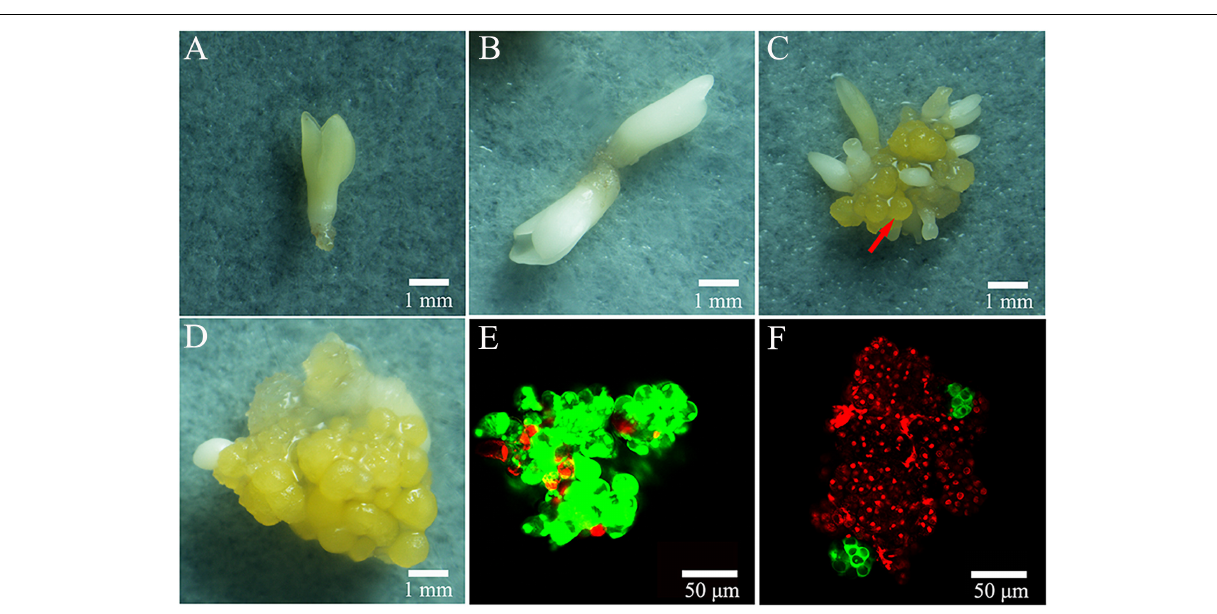
cell lines were measured and compared. Diploid and tetraploid cell lines were used to produce somatic embryos with the same method. ECAs with a diameter of 200–450 µ m were obtained